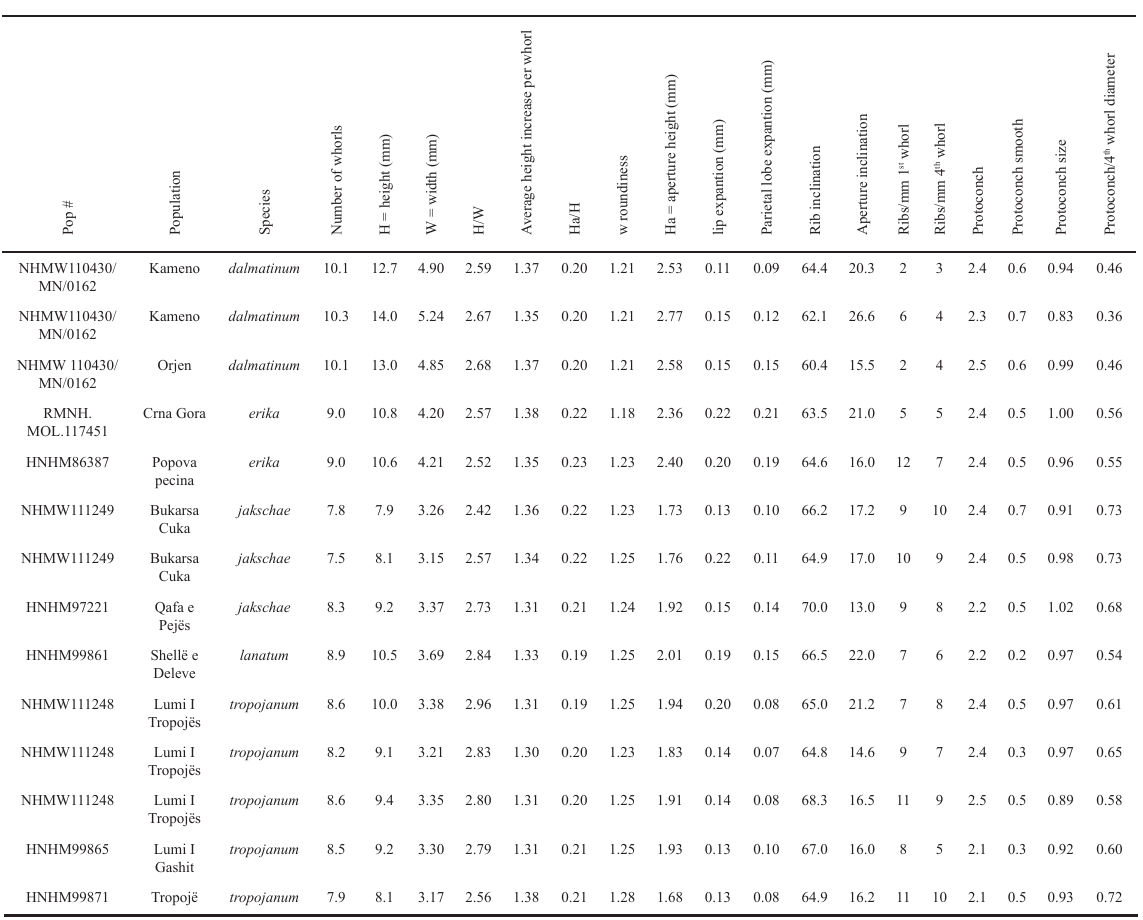
Table 3. Shell features of the analysed specimens of the 5 species of Cochlostoma (Lovcenia) Zallot et al. ,